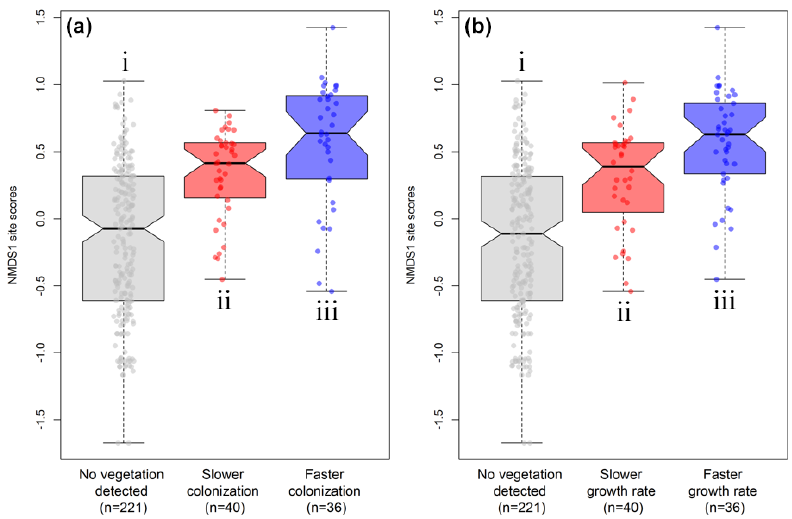
Figure 10. First axis scores of the NMDS according to the three classes of anomalies of (a) time lag and (b) growth rate for an NDVI threshold of 0.075. The letters i, ii, and iii indicate significant differences based on the Wilcoxon test ( p values <